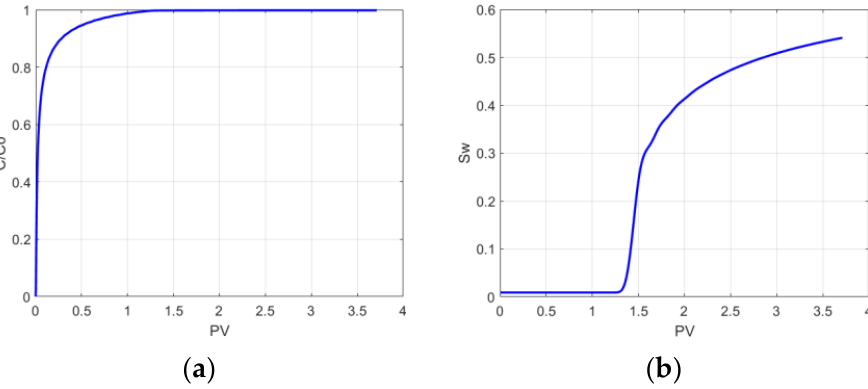
Figure 1. Nanoparticle behaviors against pore volume. ( a ) Nanoparticles concentration, ( b ) Water saturation.